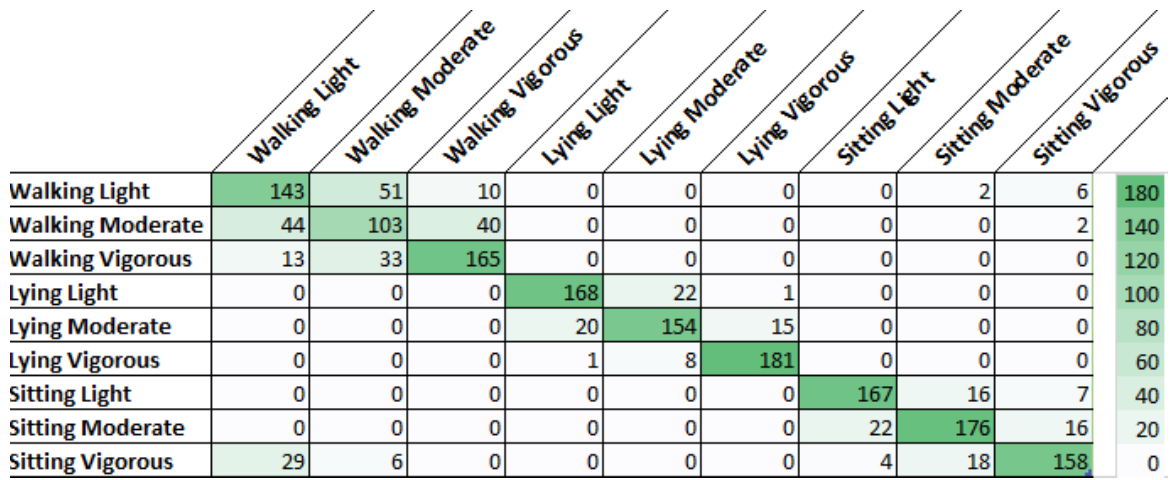
Figure 3. Confusion matrix for classification with K-Nearest Neighbors (KNN).